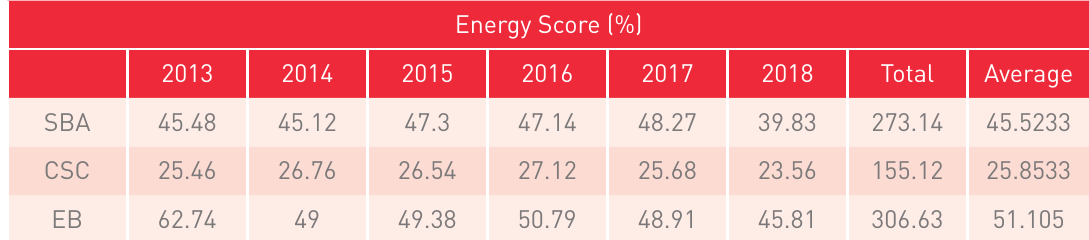
Details of the three buildings